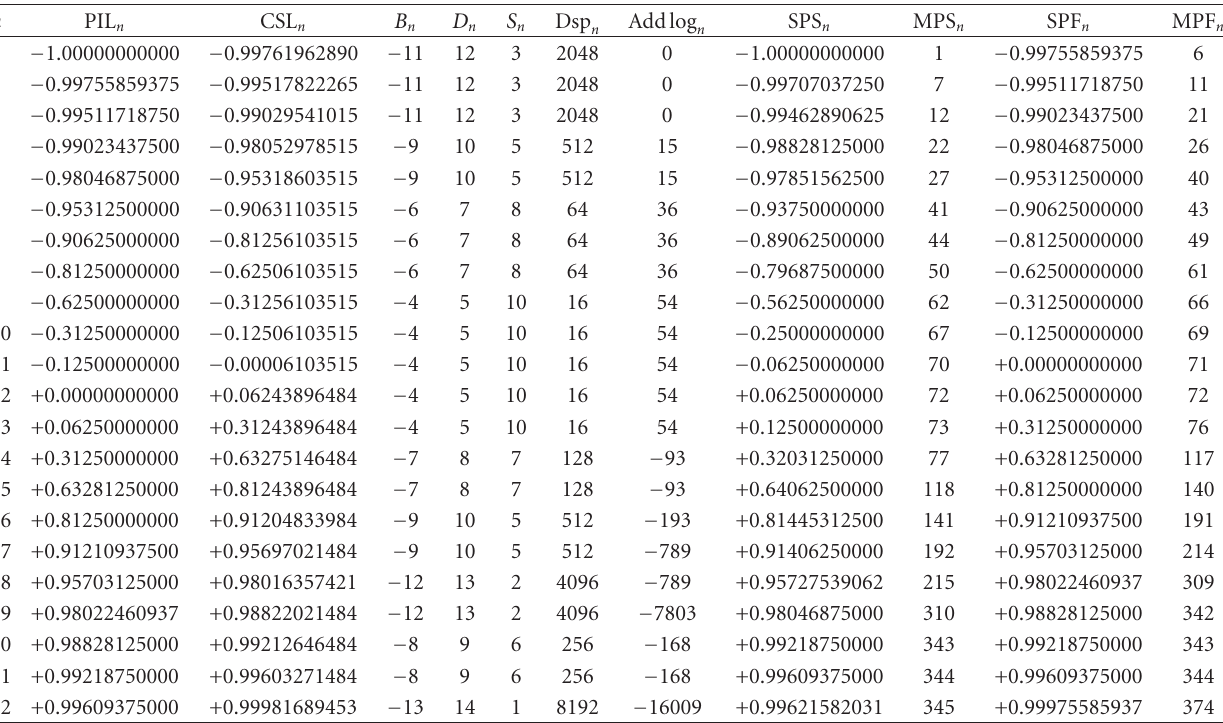
Table 5: Configuration parameters calculated for sampling scheme β .